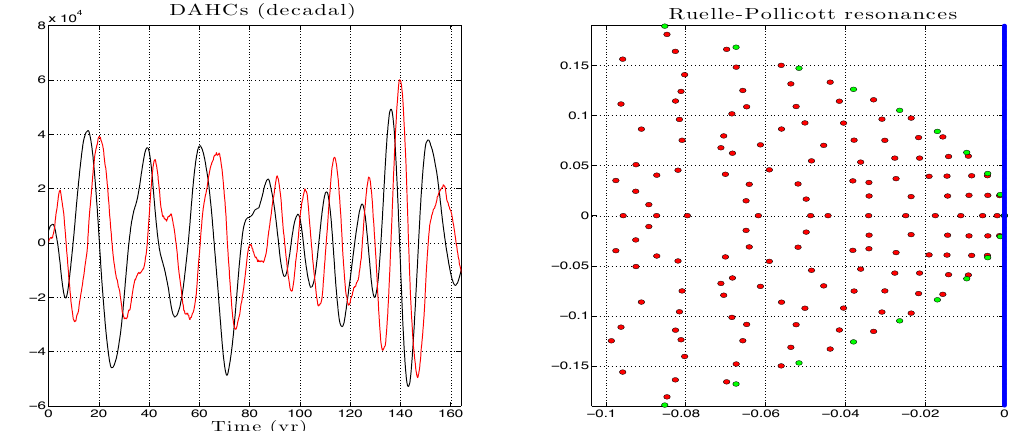
Figure A3. Reduced RP resonances and their analytic approximation. Same as in Figure A2, but for the frequency f = 0.061 cycle/ y − 1 .